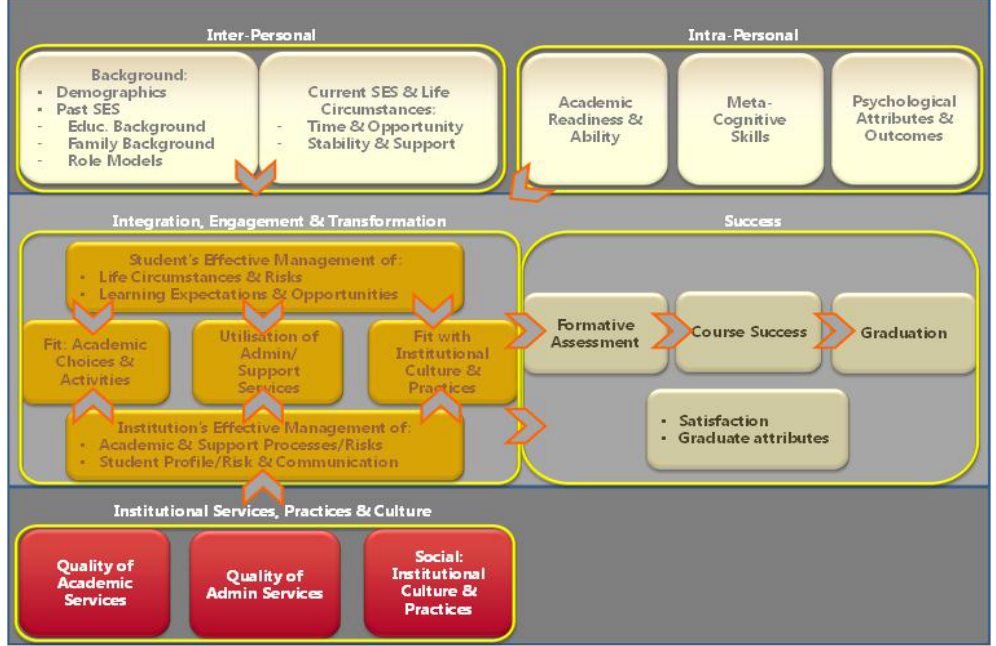
Figure 2 . Elements to be measured as part of the student success